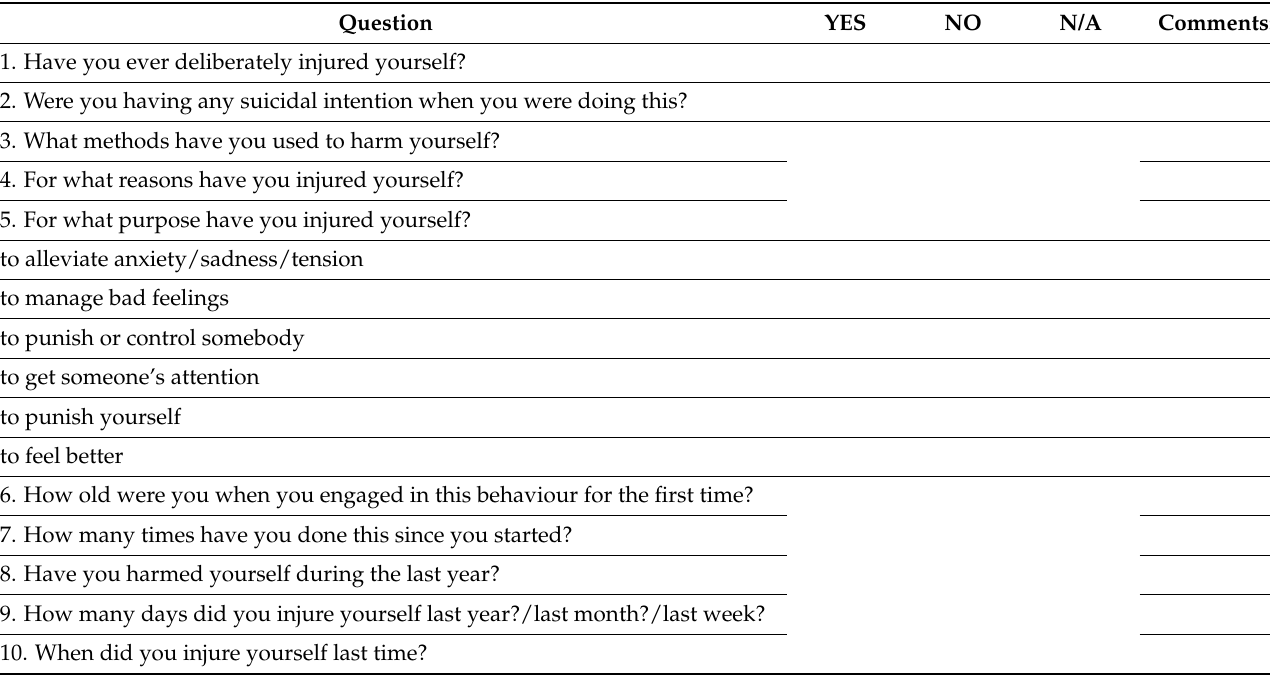
Table A1. The questionnary Used to Assess